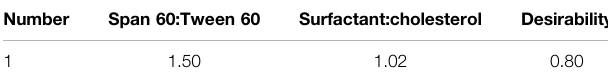
TABLE 2 | Desirability criteria and predicted values for independent variables. TABLE 3 | Comparison of the empirical and predicted values for the optimized niosomal